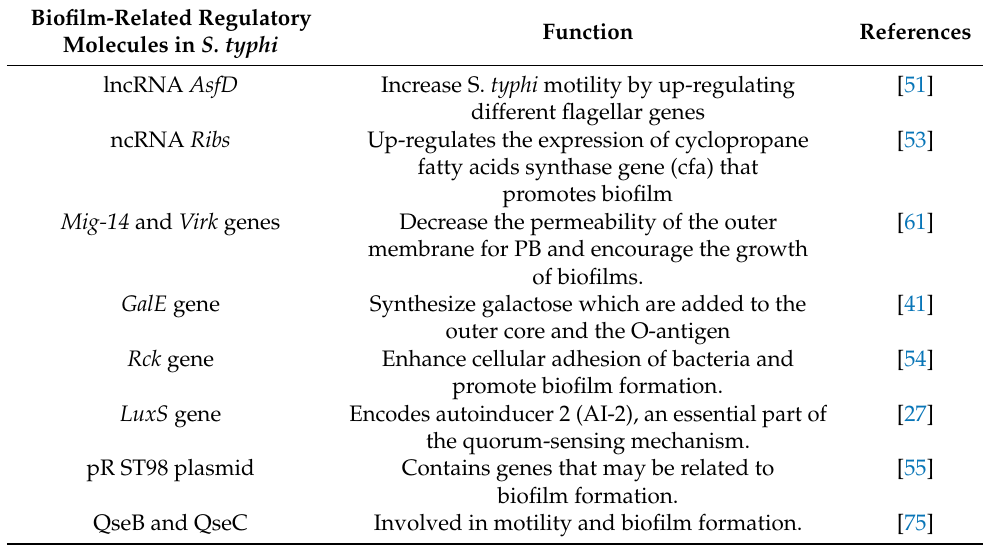
Table 1. Function of different regulatory molecules in biofilm formation of Salmonella typhi